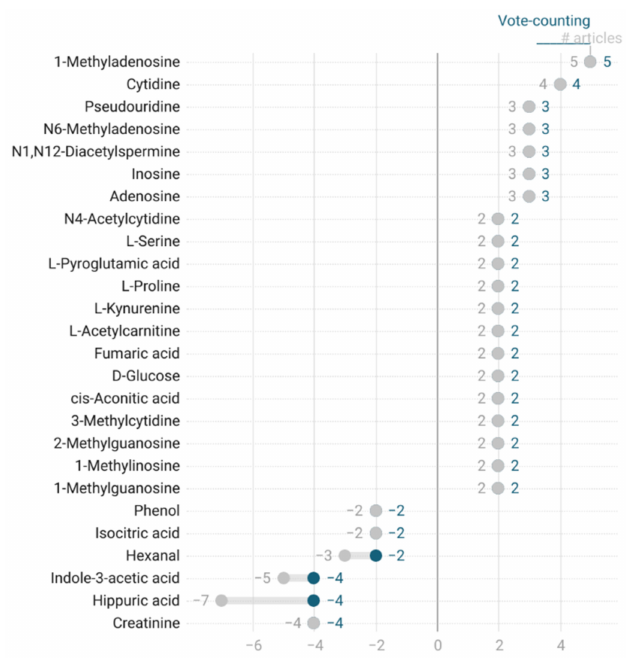
Figure 2. Qualitative vote-counting of colorectal cancer-related compounds, as a range plot between vote-counting values (blue) and total number (#) of articles (gray) from where the vote-counting is calculated. Positive values are compounds upregulated in CRC, while negative values are compounds downregulated in